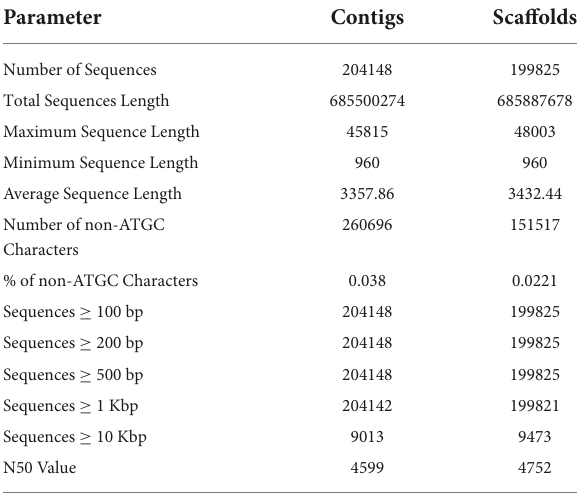
TABLE 3 Pongamia genome assembly statistics showing the contigs and scaffold features.